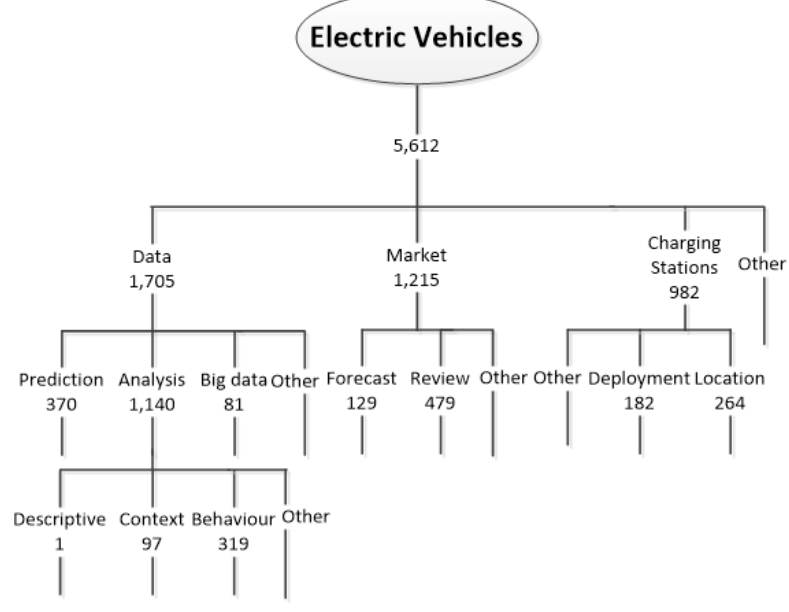
Figure 3. Hierarchy of keywords for related work